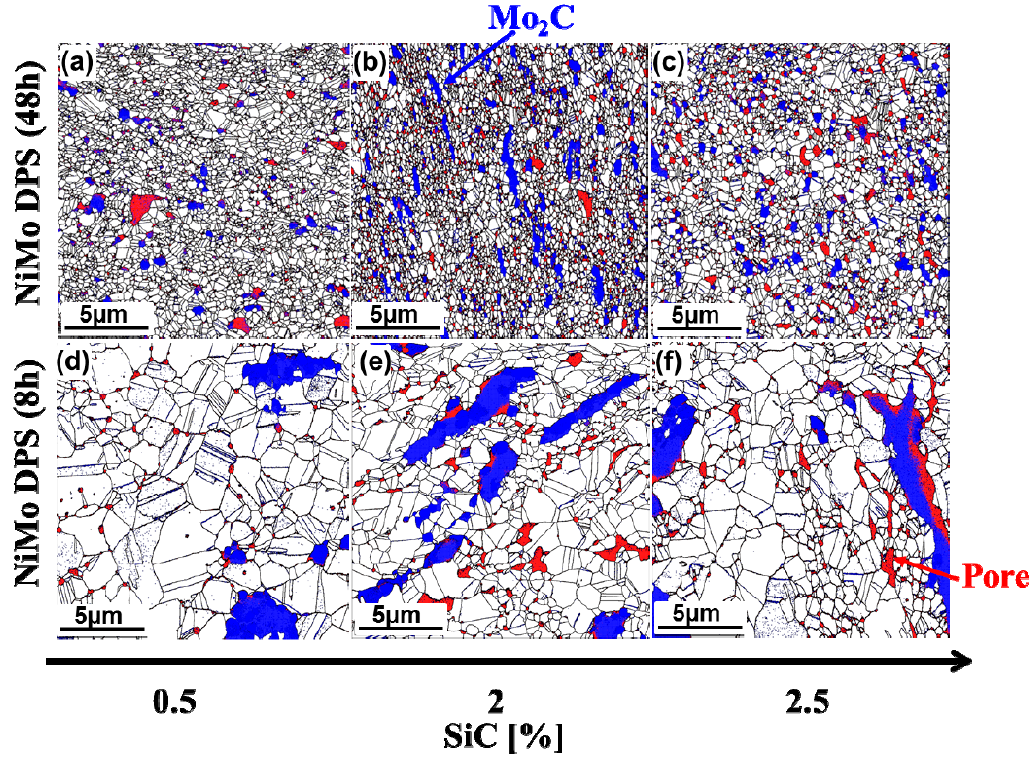
Figure 7. Electron Back Scattering Diffraction (EBSD) plots of Mo 2 C distribution in 48-h-milled NiMo-SiC DPS alloys with the initial SiC content of ( a ) 0.5, ( b ) 2 and ( c ) 2.5 wt %, and 8-h-milled NiMo-SiC DPS alloys with the initial SiC contents of ( d ) 0.5, ( e ) 2 and ( f ) 2.5 wt %. Blue areas show Mo 2 C distribution and red areas show pores, within the matrix (white areas).